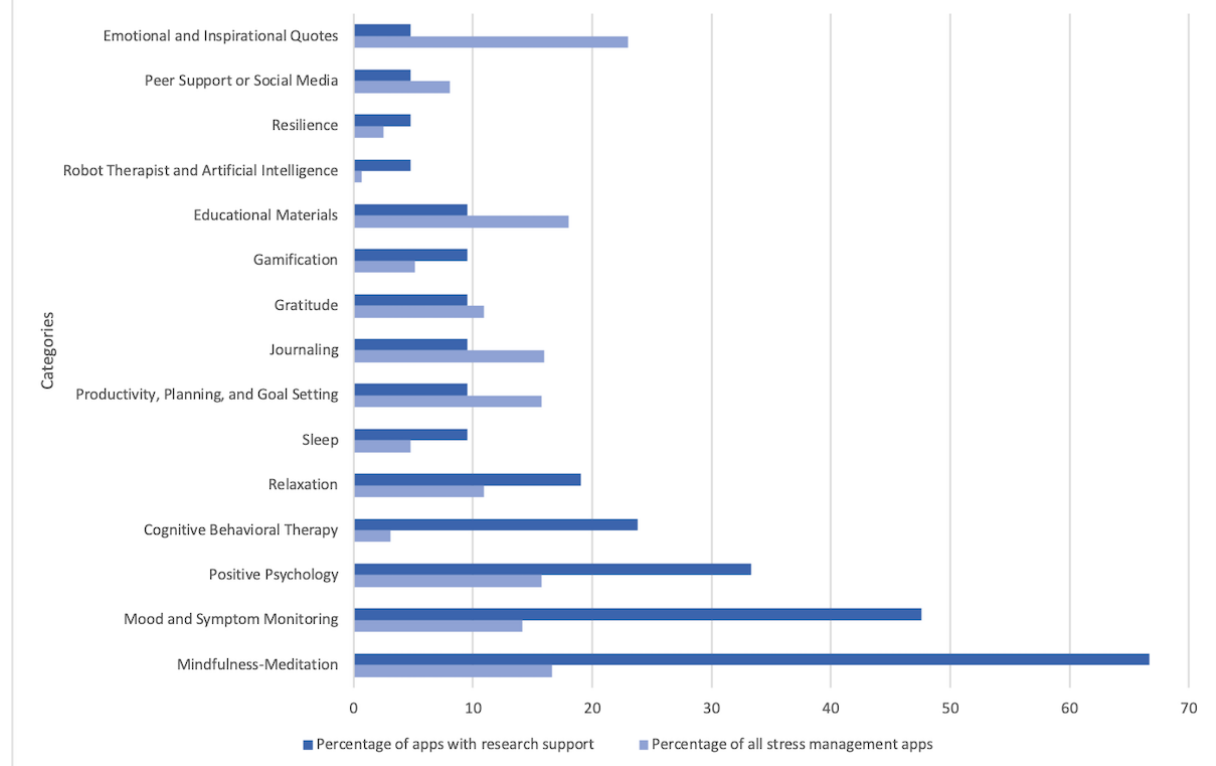
Figure 3. Intervention and didactic content for research-supported apps (n=21) vs all stress management apps (N=1009). Content categories were assigned based on descriptions by the app developer. Categories were not mutually exclusive, and a single app could be represented across one or